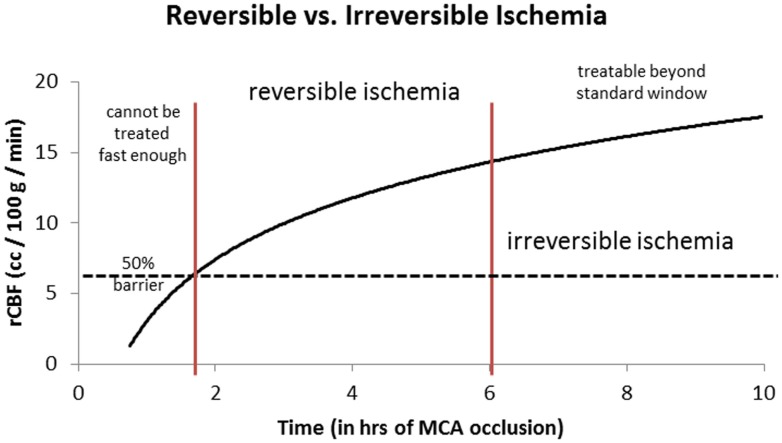
Logarithmic time curve: the infarction threshold distinguishing between reversible and irreversible ischemia as a function of rCBF and time from ictus. Time window here is an approximation. The vertical lines are an approximation and have not yet been validated (20).